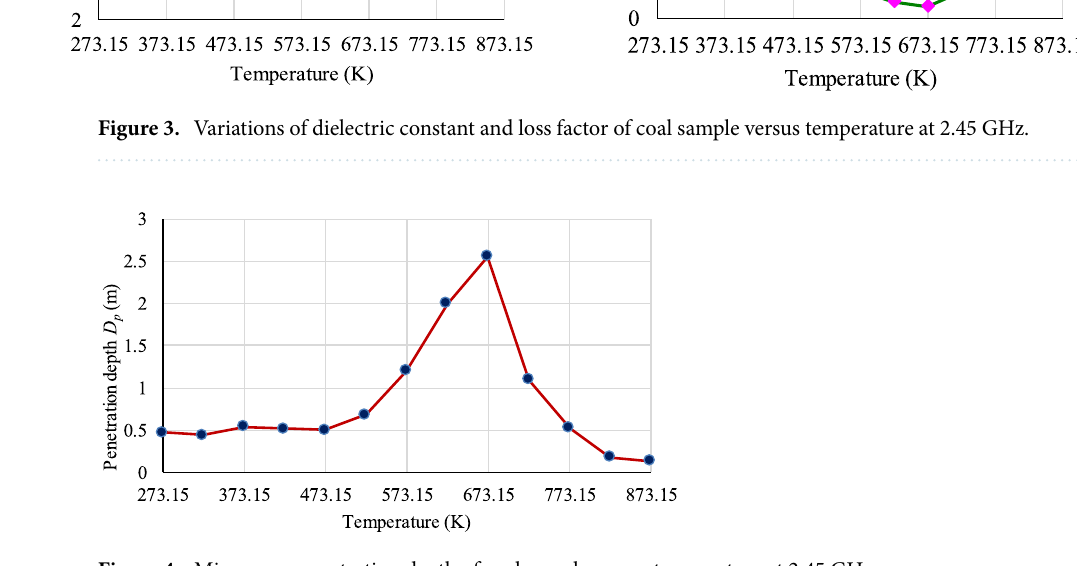
Figure 4. Microwave penetration depth of coal sample versus temperature at 2.45